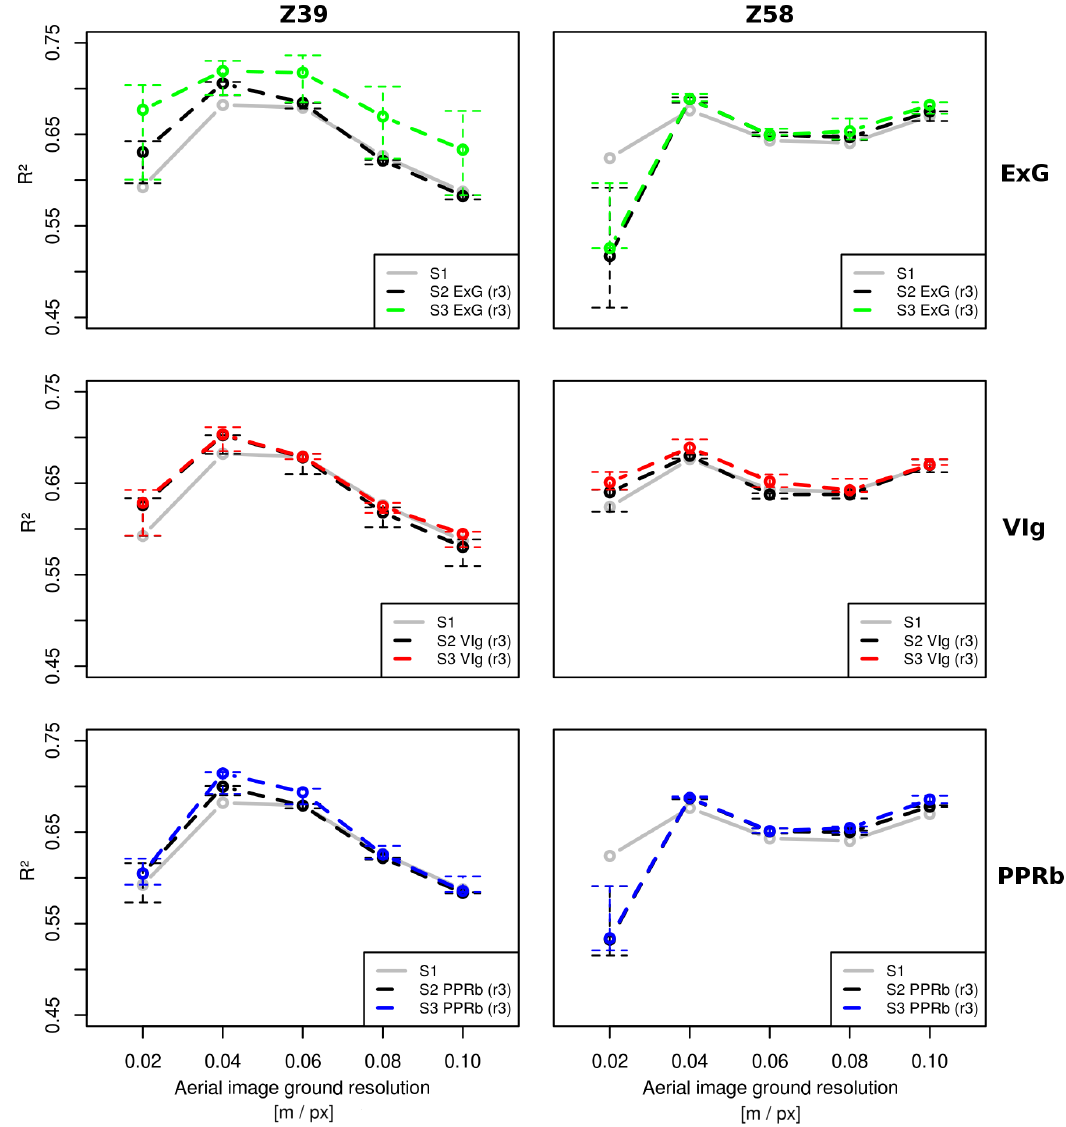
Figure 5. Resulting determination coefficients R 2 of modeling strategies S for all VIs and 1 − 3 aerial image ground resolutions at crop growth stages Z39 and Z58. Grey values represent R 2 values for strategy S , whereas black values represent strategy S at Ridler threshold r 1 2 3 and colored values represent strategy S at Ridler threshold r , respectively. In addition to 3 3 the R 2 values of strategies S and S at Ridler threshold r , minimum and maximum R 2 2 3 3 values of the four remaining threshold variants are indicated as range bars for every aerial image ground resolution